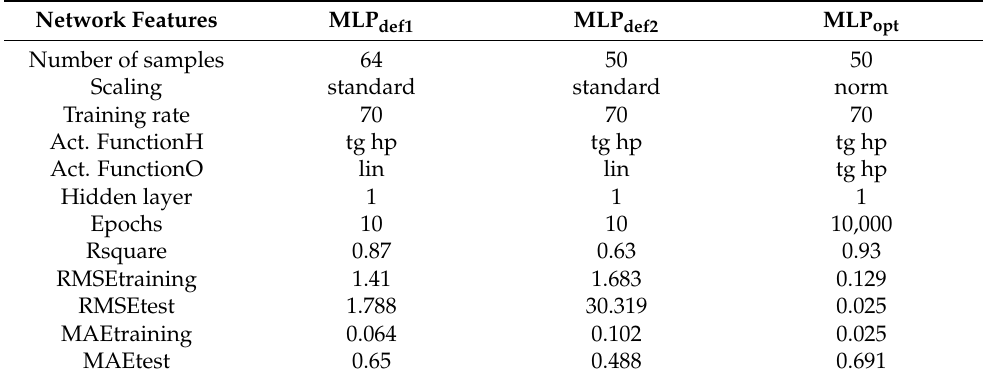
Table 6. Comparison of model’s